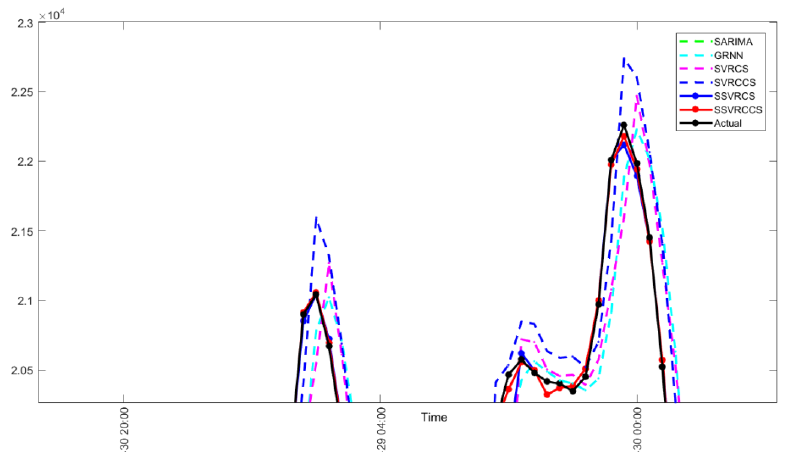
Figure 12. The enlargement comparison of Peaks 3 and 4 from the compared models for Example 2.